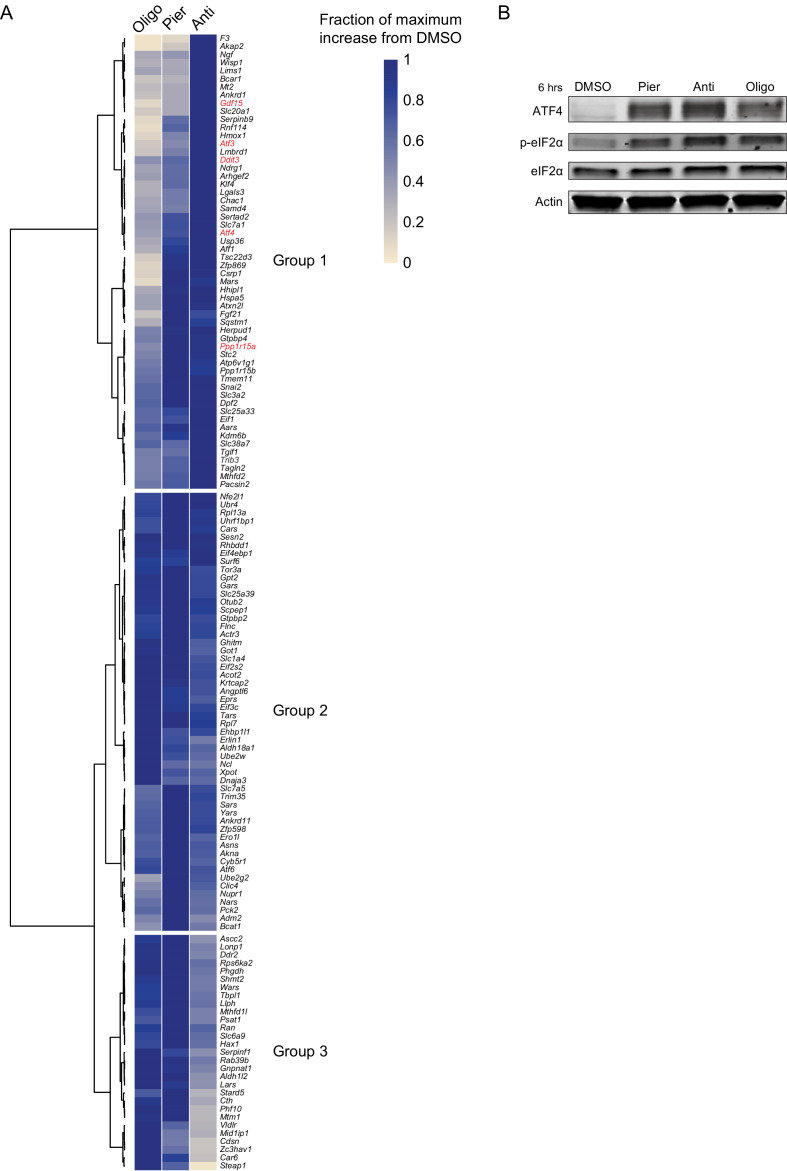
Additional data on transcriptional and protein markers of the ISR following mitochondrial inhibitor treatments in myoblasts.(A) Heatmap of mean expression fold-changes derived from RNA-seq for upregulated ATF4/DDIT3 target genes most associated with PC1 (jackstraw p-value<0.0001). Atf4 was also included. Data was min-max normalized such that in each row, the treatment that elicited the maximum upregulation from the DMSO baseline was assigned the value one and the remaining treatments were assigned the fraction of the maximum upregulation they elicited. Rows (genes) were then hierarchically clustered based on Pearson correlation using Ward agglomeration. The first three branching points in the dendrogram define Groups 1–3, as referenced in the main text. Genes in red are used throughout this manuscript as markers of the ISR. See also Supplementary file 1. (B) Western blot of ATF4 and (p-)eIF2α in myoblasts treated for 6 hr as indicated. Pier, piericidin; Anti, antimycin; Oligo, oligomycin.